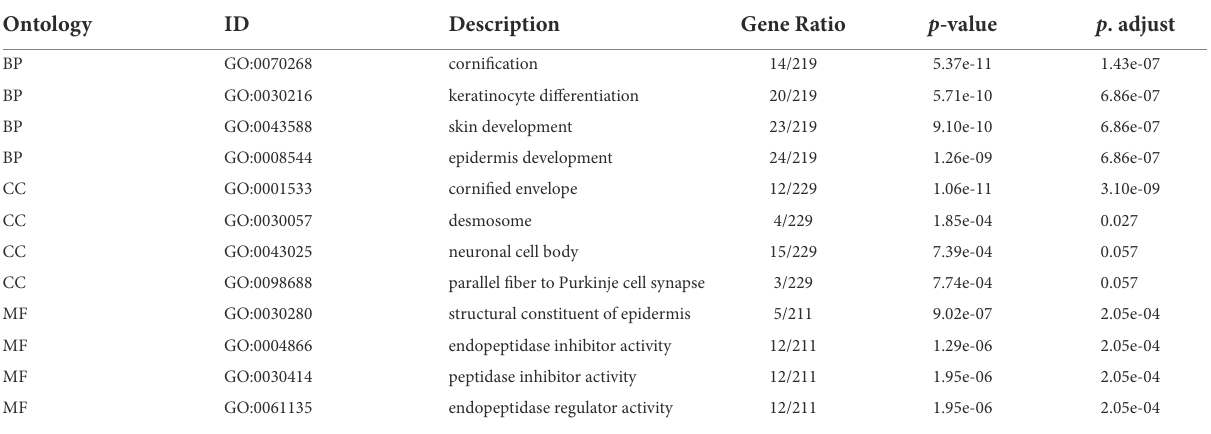
TABLE 2 GO analysis of DEGs in GSE23586 and GSE7621.